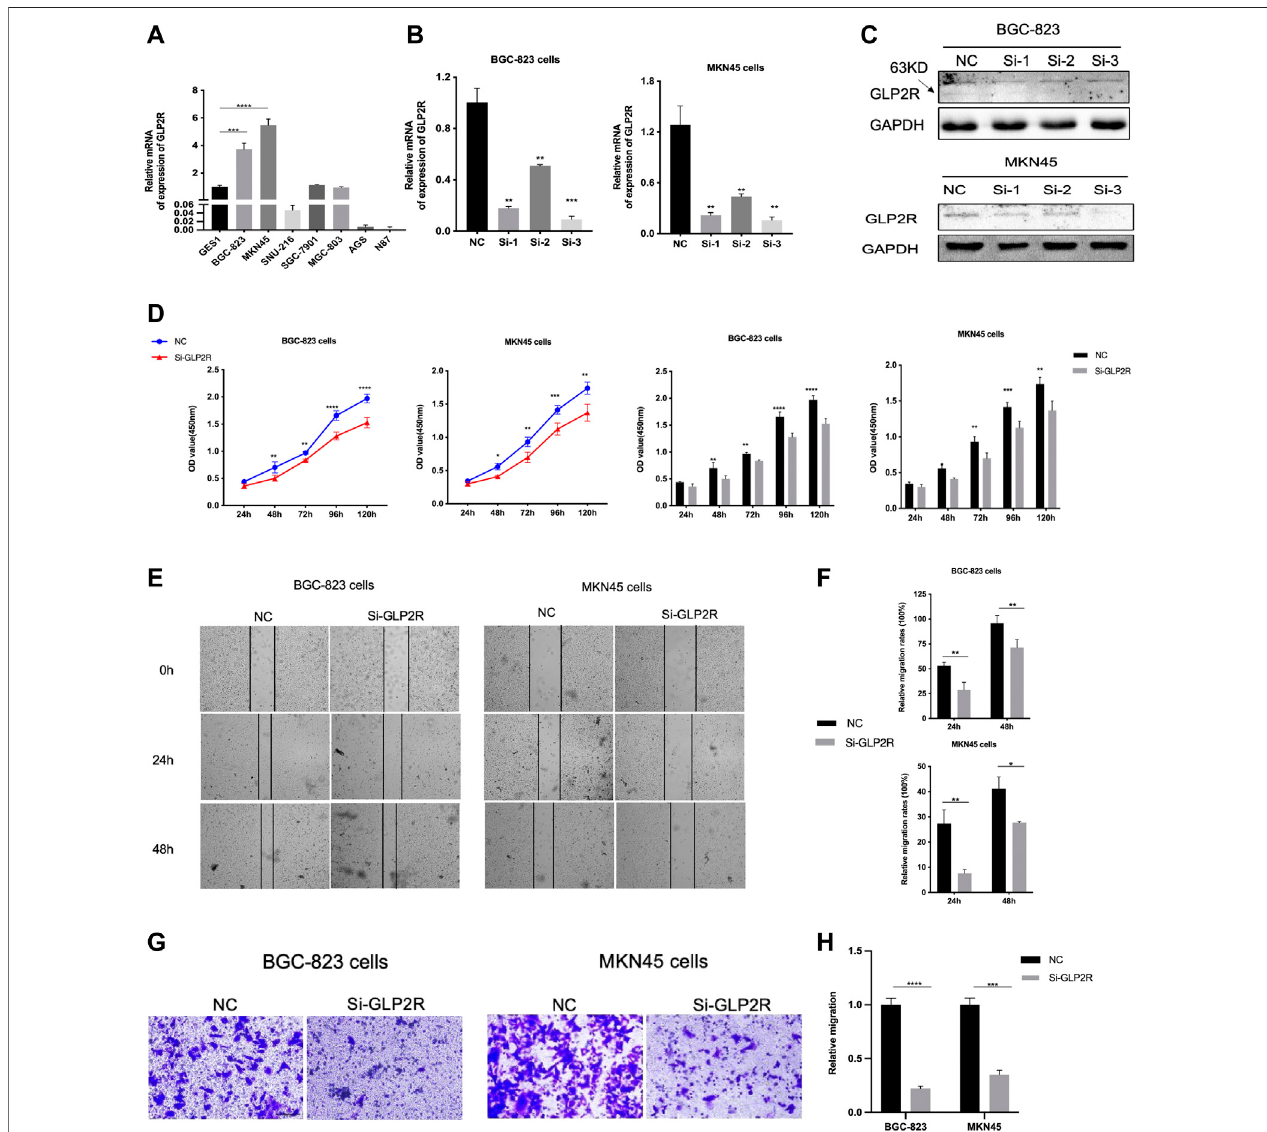
FIGURE 13 | Knockdown of GLP2R inhibits proliferation, migration of gastric cancer cells. (A) The relative expression level of GLP2R in the GES1, BGC-823, MKN45, SNU-216, SGC-7901, MGC-803, AGS and N87 cell lines detected by RT-PCR. (B) The transfection ef fi ciency of si-GLP2R in the BGC-823 and MKN45 cell lines detected by RT-PCR. (C) Western blot analysis con fi rmed that the expression of GLP2R was inhibited by GLP2R siRNA administration. (D) The CCK-8 assay was used to detect the effect of si-GLP2R on the proliferation of BGC-823 and MKN45 cell lines. (E) Representative images of the wound healing assay. (F) Statistical analysis of the wound healing assay results after Knockdown of GLP2R. (G) Representative images of the transwell assay. (H) Statistical analysis of the transwell assay results after Knockdown of GLP2R in the BGC-823 and MKN45 cell lines.* p < 0.05, ** p < 0.01, and *** p < 0.001.